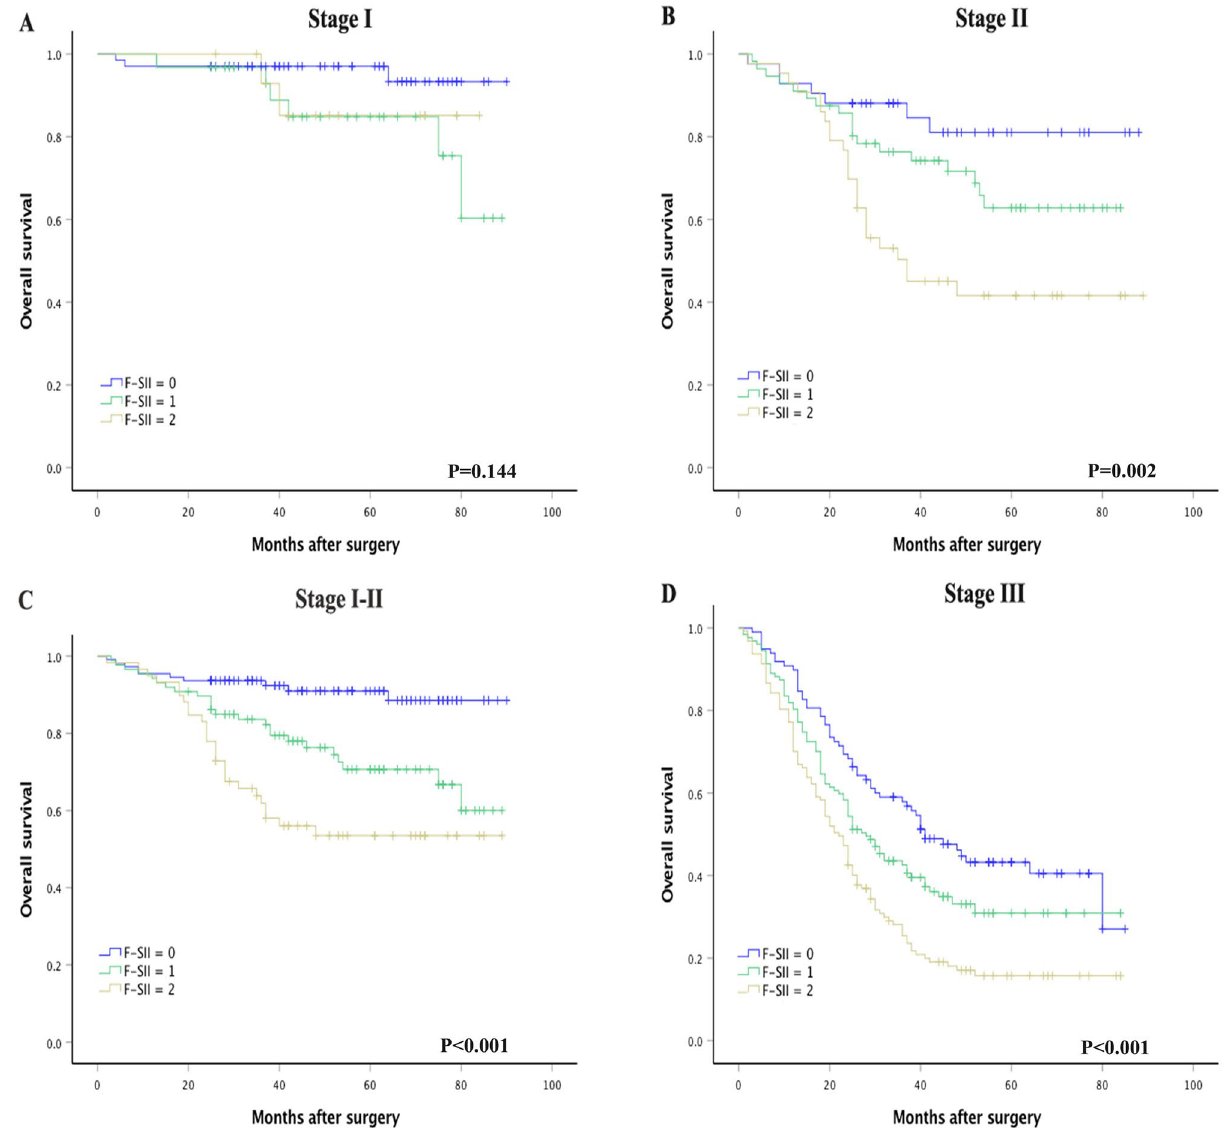
Figure 2. Kaplan–Meier analysis of OS of GC patients at each TNM stage according to the F-SII score. ( A ) Association of the F-SII score with the OS of patients with stage I GC. ( B ) Association of the F-SII score with the OS of patients with stage II GC. ( C ) Association of the F-SII score with the OS of patients with stage I-II GC. ( D ) Association of the F-SII score with the OS of patients with stage III